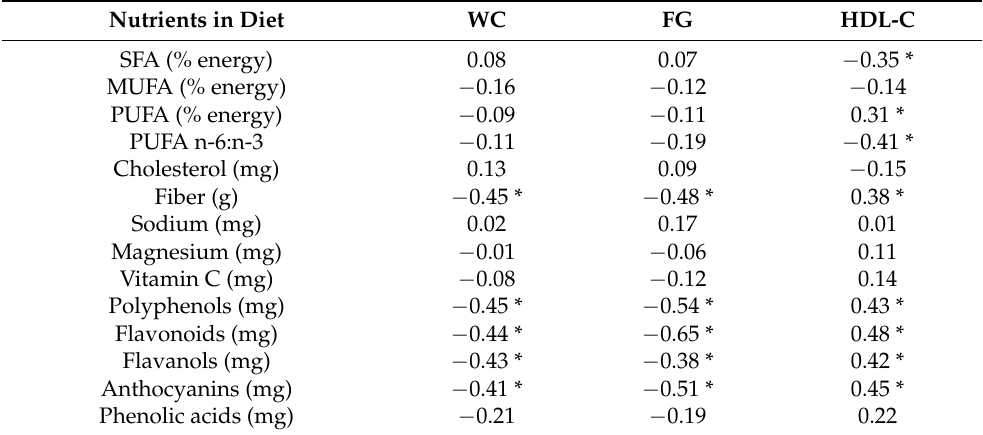
Table 6. Correlations between dietary nutrients and MetS risk factors post-intervention in the INEG.